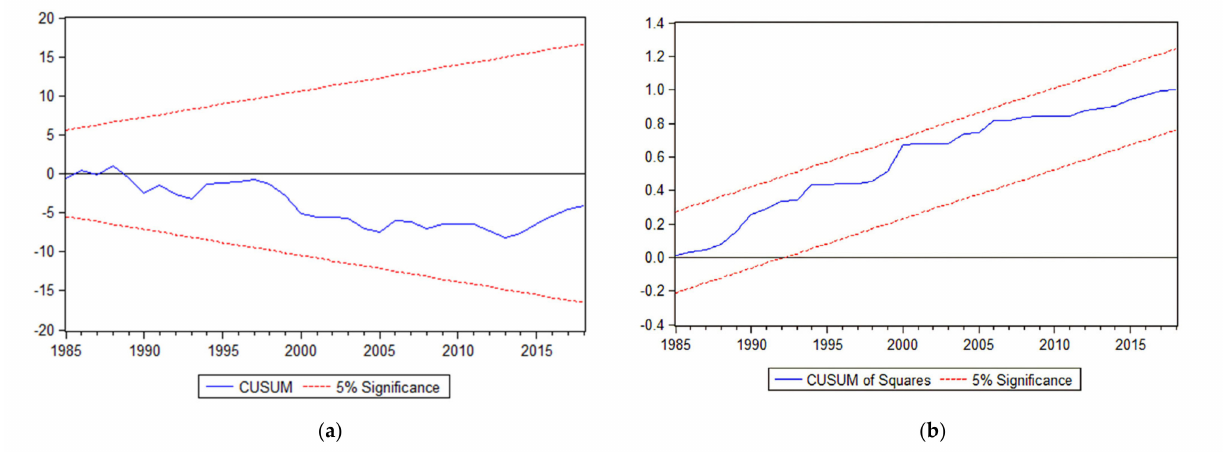
Figure 4. ( a ) The cumulative sum of recursive residuals; ( b ) the cumulative sum of squares of recursive